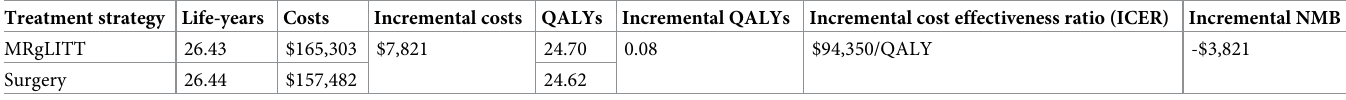
Table 4. Base case analysis.